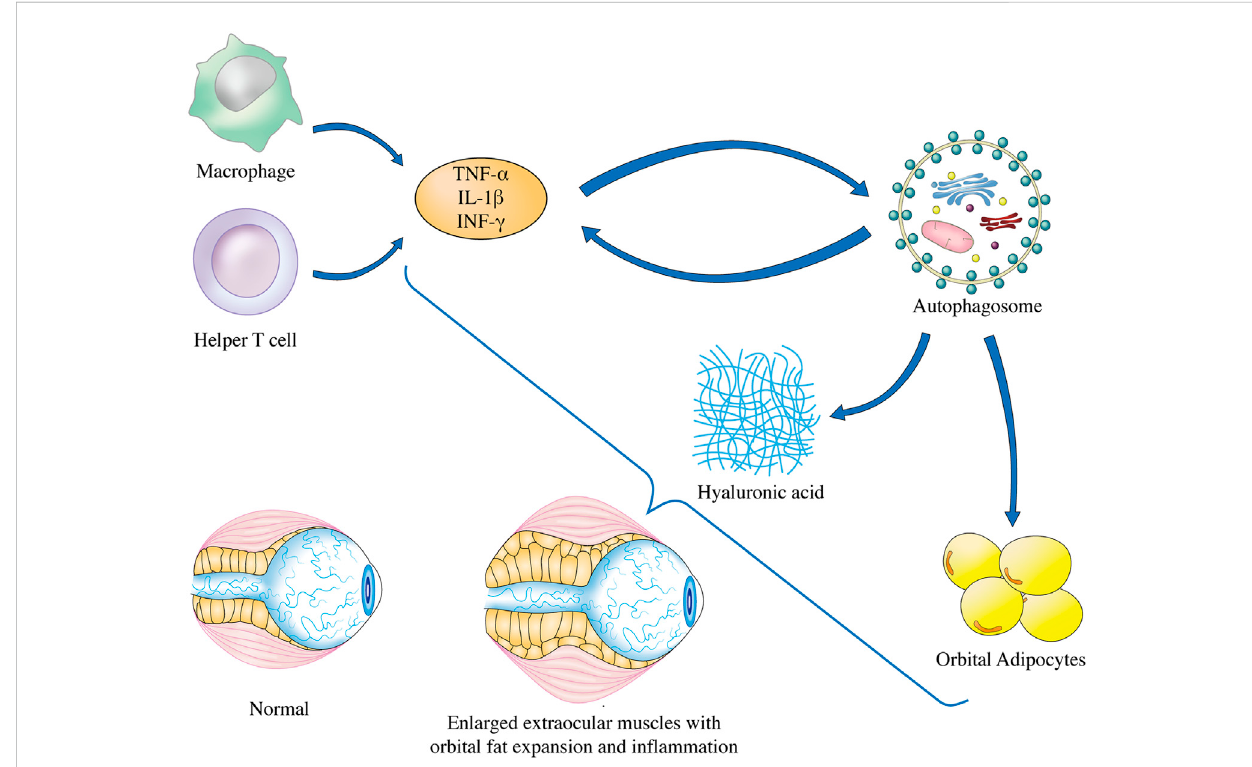
FIGURE 2 Autophagy regulation in GO pathogenesis. The underlying mechanisms of GO has been linked to in fl ammation, adipogenesis, and GAG accumulation in OFs, and fi nally lead to enlarged extraocular muscles with orbital fat expansion. Elevated secretion ofin fl ammatory factors such as TNF- α , IL-1 β , and INF- γ is associated with the induction of autophagy in OFs of GO. Progression of OFs adipogenesis can be mitigated by inhibition of autophagy. Furthermore, lysosomal inhibitors can reduce GAG accumulation through blocking the autophagic fl ux of OFs in GO. TNF- α , tumor necrosis factor-alpha; IL-1 β , interleukin-1 beta; INF- γ ,